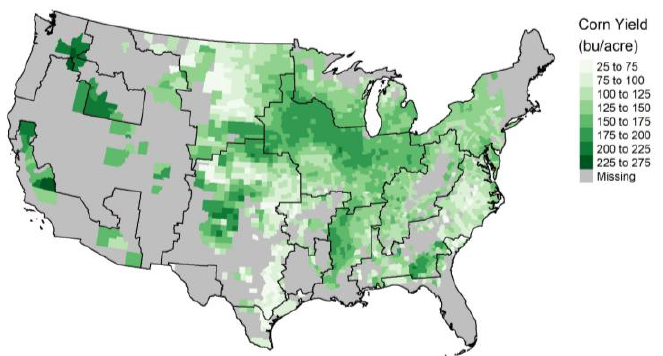
Figure 1. Farm Resource Region (FRR) boundaries and average corn yield (bushels per acre) recorded in USDA-NASS Surveys between 2008 and 2018; µ panel = 142.2 bushels/acre (9.56 tons/hectare), sd panel = 39.4 bushels/acre (2.65 tons/hectare). FRRs as follows: (1) Heartland; (2) Northern Crescent; (3) Northern Great Plains; (4) Prairie Gateway; (5) Eastern Uplands; (6) Southern Seaboard; (7) Fruitful Rim; (8) Basin and Range; and (9) Mississippi Portal. The “missing” category refers to all counties where NASS reported no corn yields from 2008 – 2018.